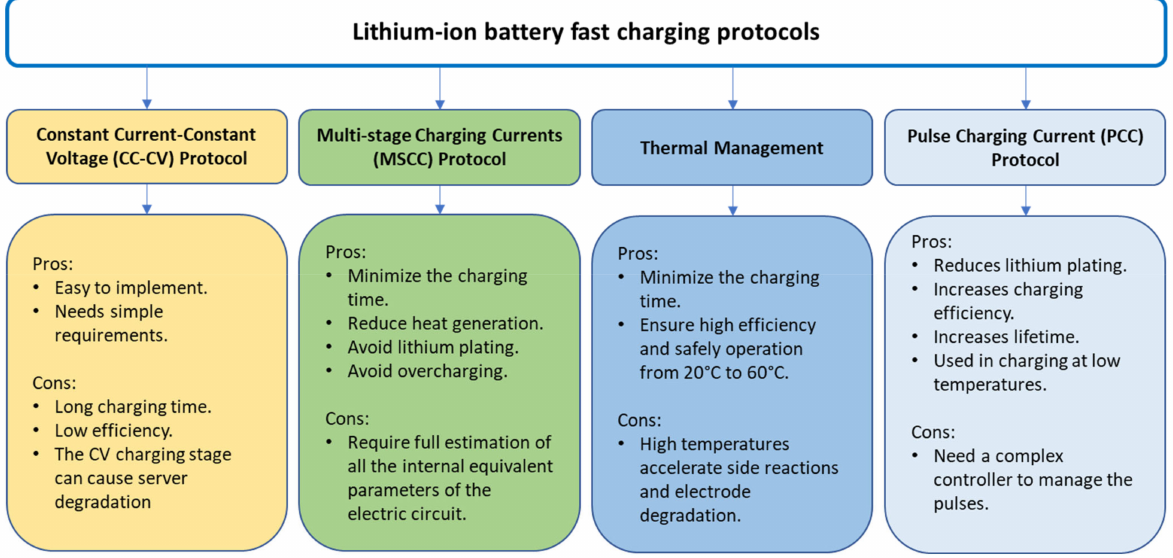
Figure 10. The pros and cons of the power management protocol with all its